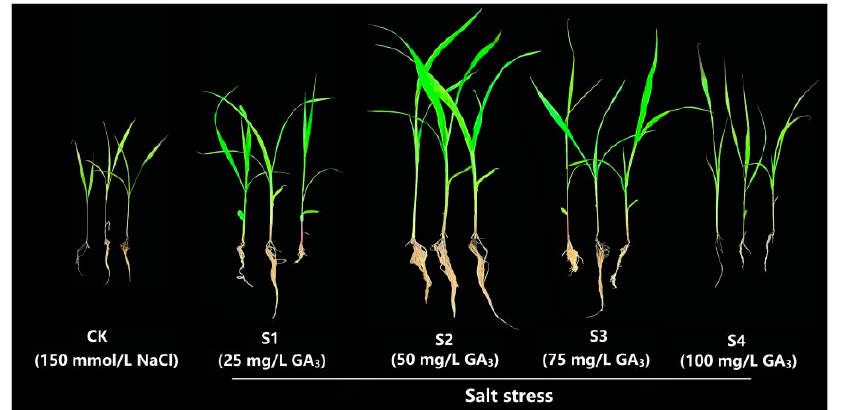
Figure 1. Phenotypic difference of the sorghum with exogenous gibberellic acid (GA 3 ) exposure under salinity-stressed conditions. All sorghum plants were subjected to salt stress via the addition of 150 mM NaCl solution. CK represents the control group with salt stress. S1~S4 represent the experimental leaves with 25 mg/L GA 3 , 50 mg/L GA 3 , 75 mg/L GA 3 , and 100 mg/L GA 3 treatment under salt stress, respectively.